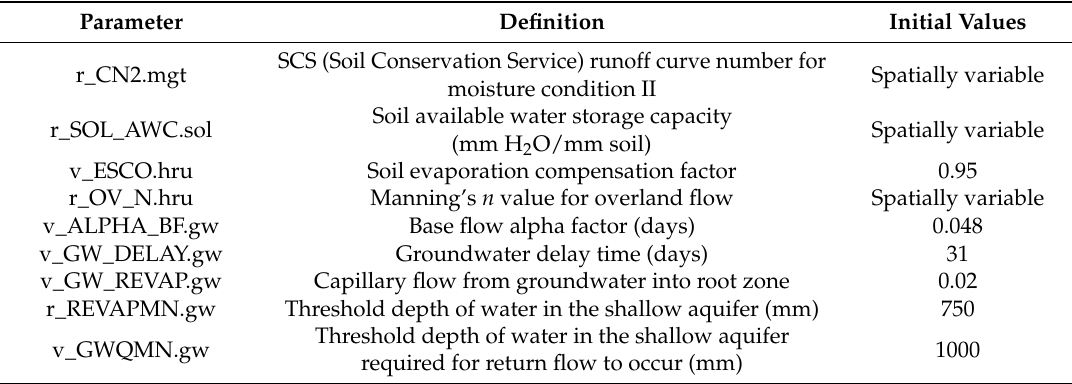
Table 3. List of parameters included in the calibration of the eight different configurations and their